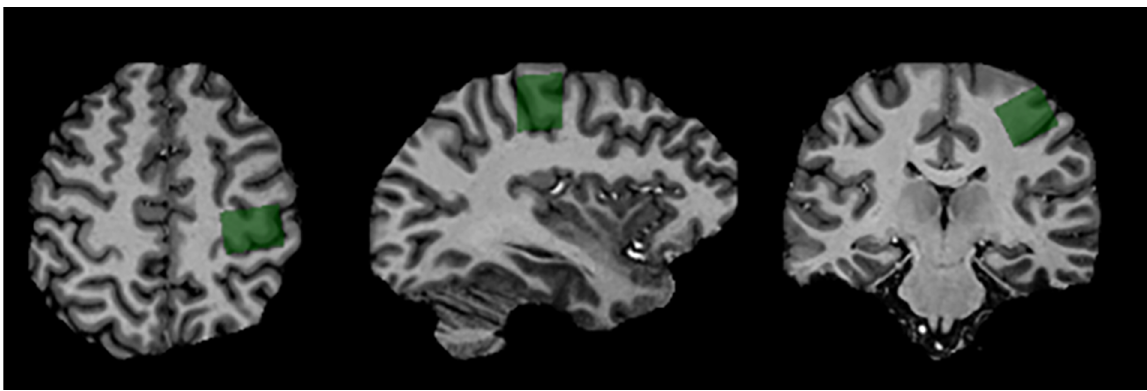
Fig 1. Voxel positioning. Typical MP2RAGE anatomical images used for voxel placement were brain extracted using FSL. The voxel shown in green (2x2x2 cm 3 ) was placed over the left primary motor cortex (under the cathode).